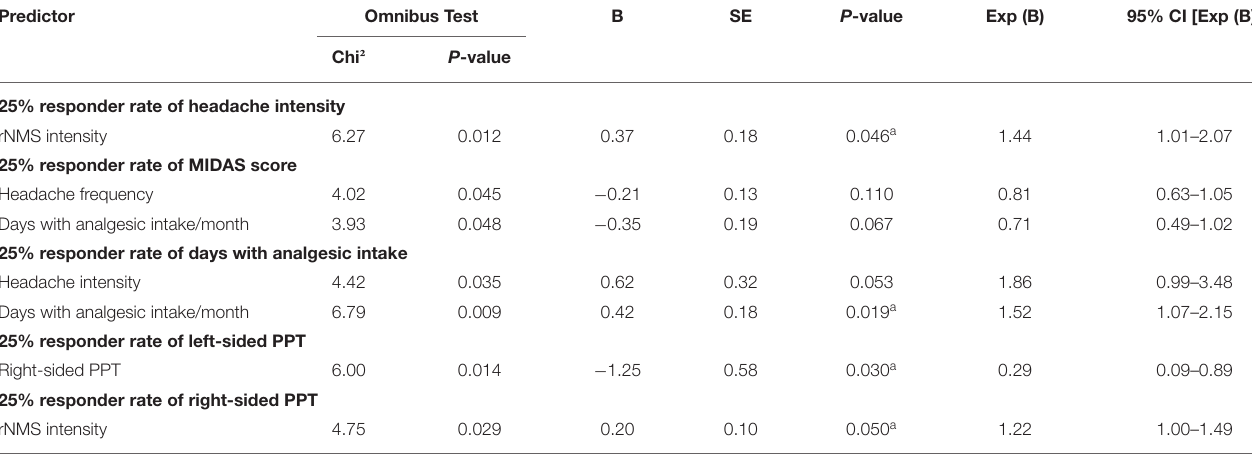
TABLE 2 | Results of the univariate analyses of response predictors of repetitive neuromuscular magnetic stimulation applied to the trapezius muscles in patients affected by episodic migraine. Predictor